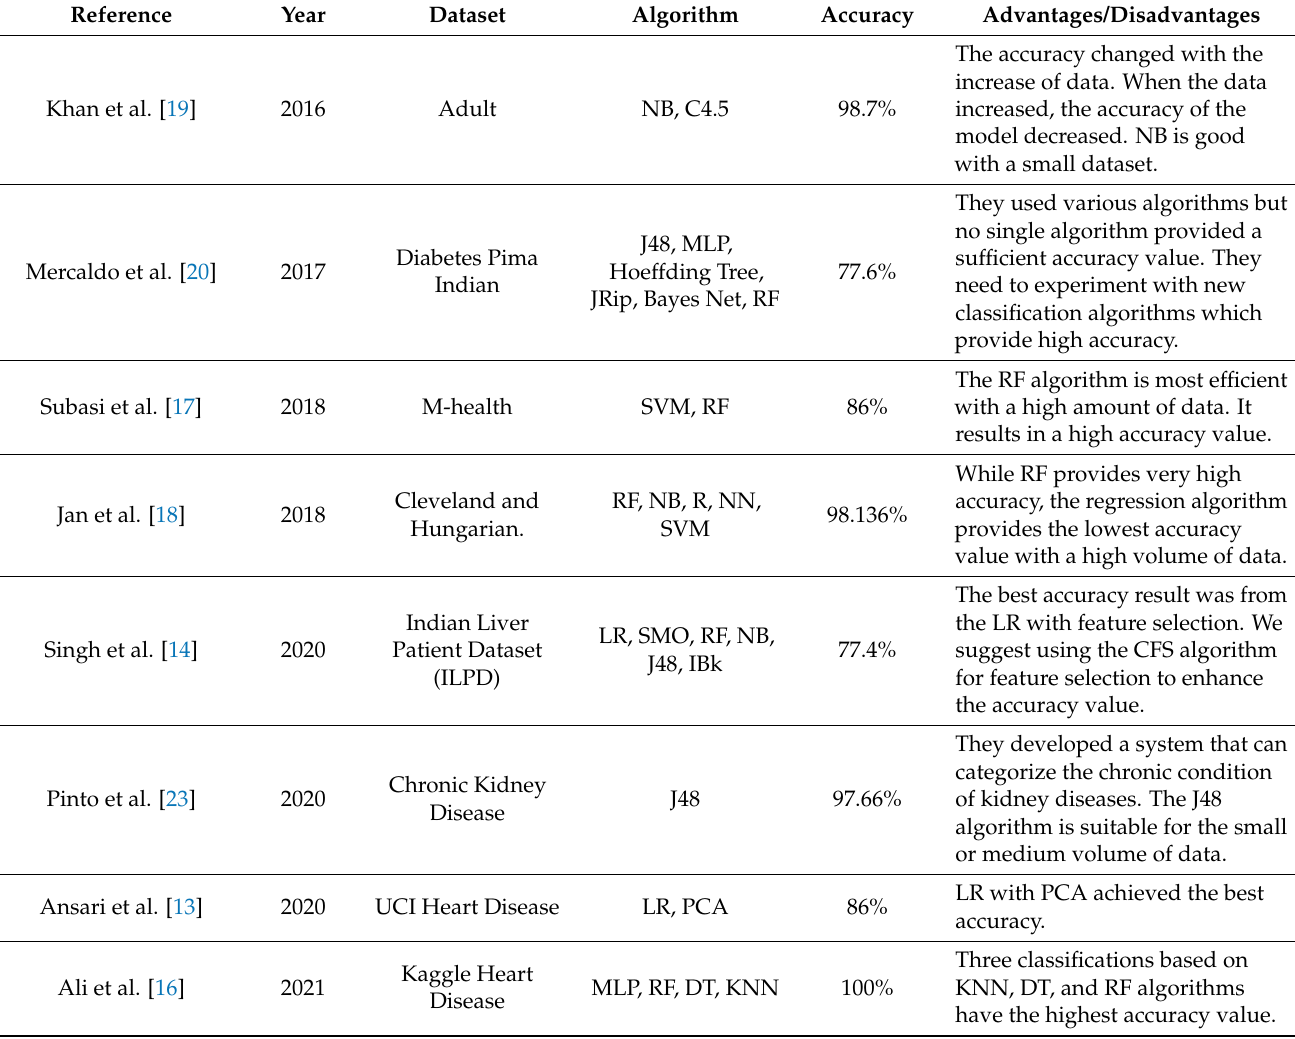
Table 1. Comparison between different research studies on medical